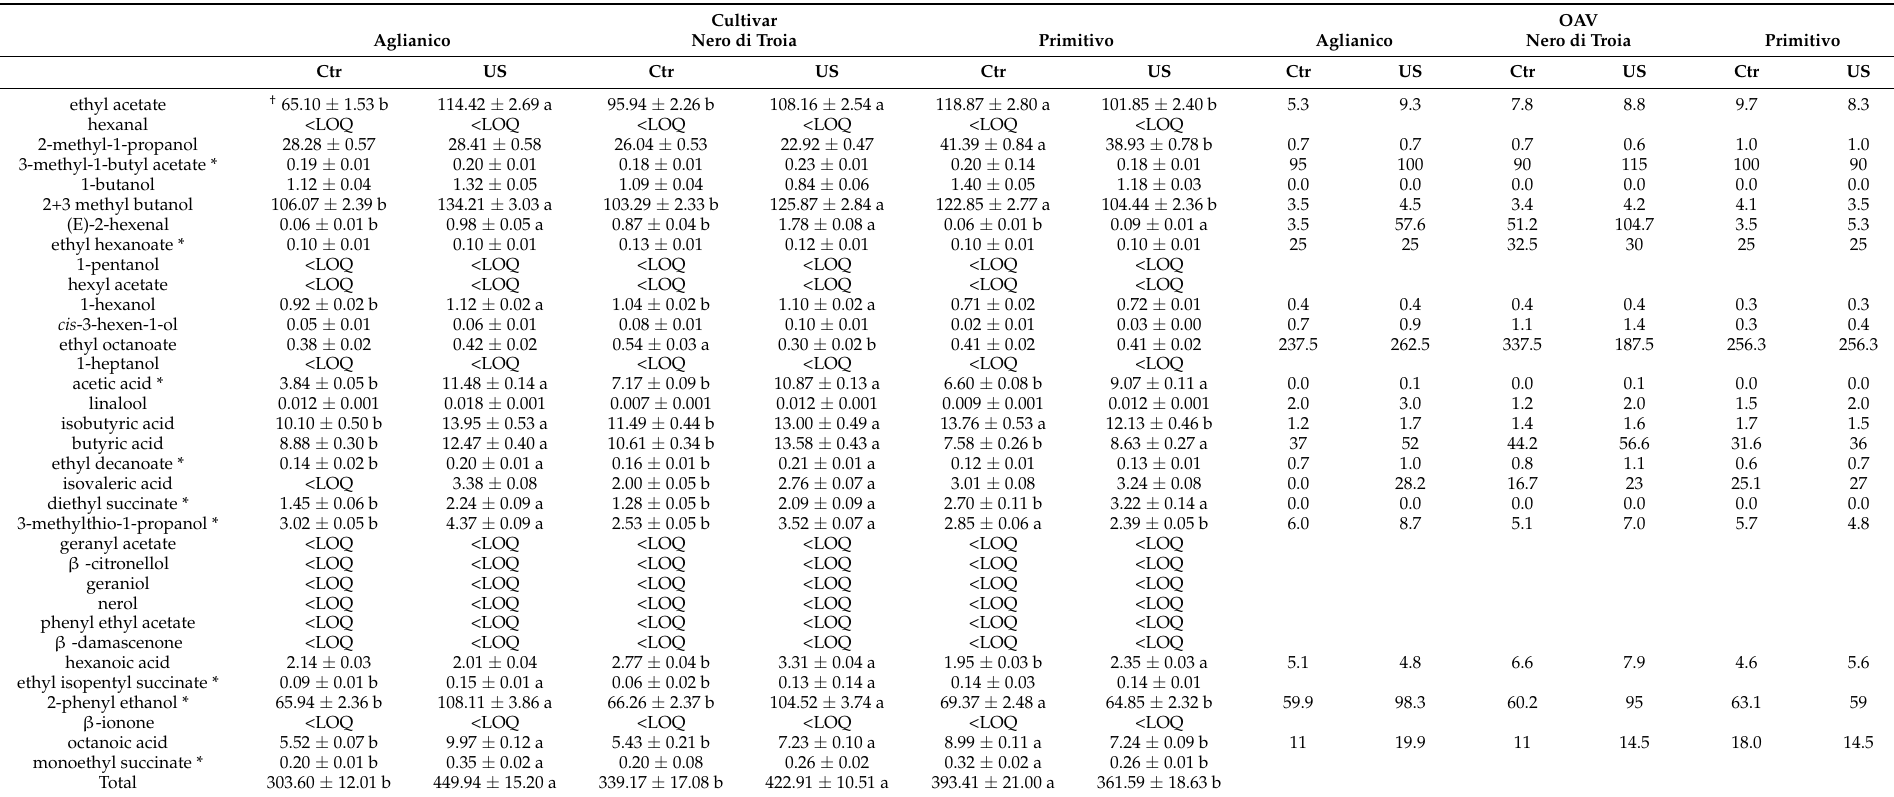
Table 3. Single volatile compounds identified and quantified in control and ultrasound-treated wine samples after 14 months of aging (mg L − 1